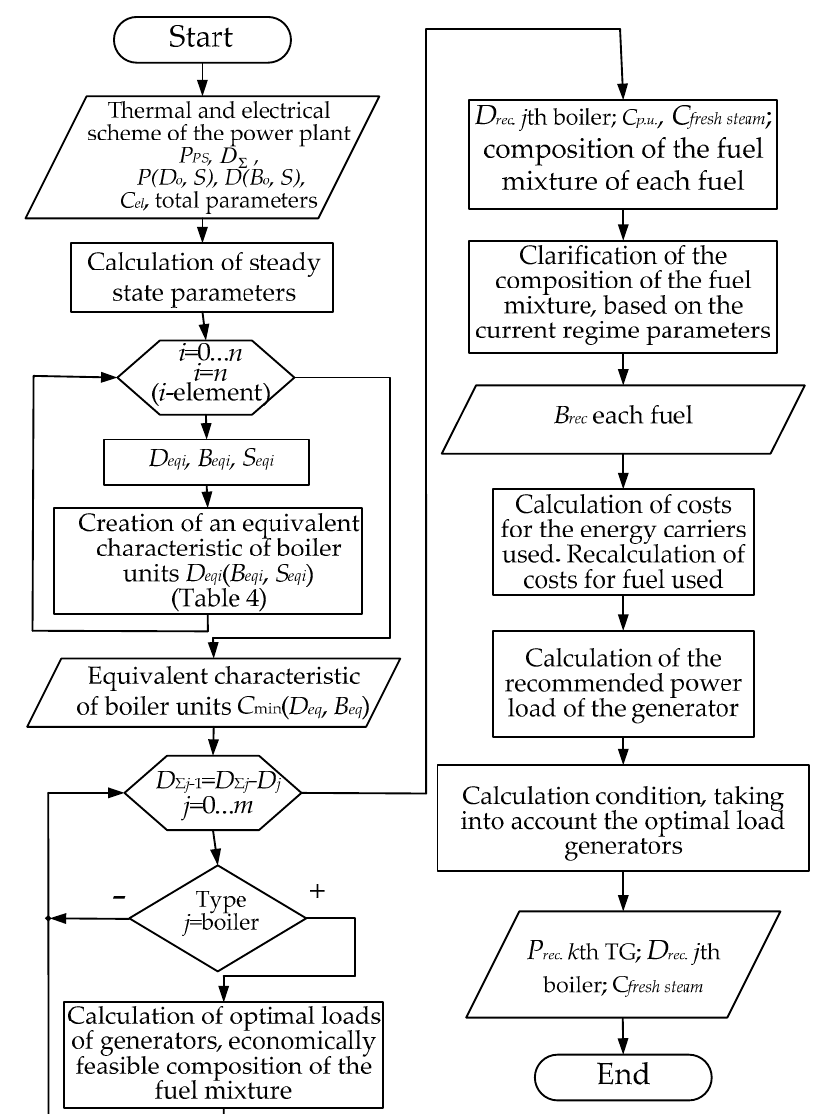
Figure 2. Flowchart for Optimizing the Operation of Boilers of an Industrial Enterprise’s Internal Power Plants.